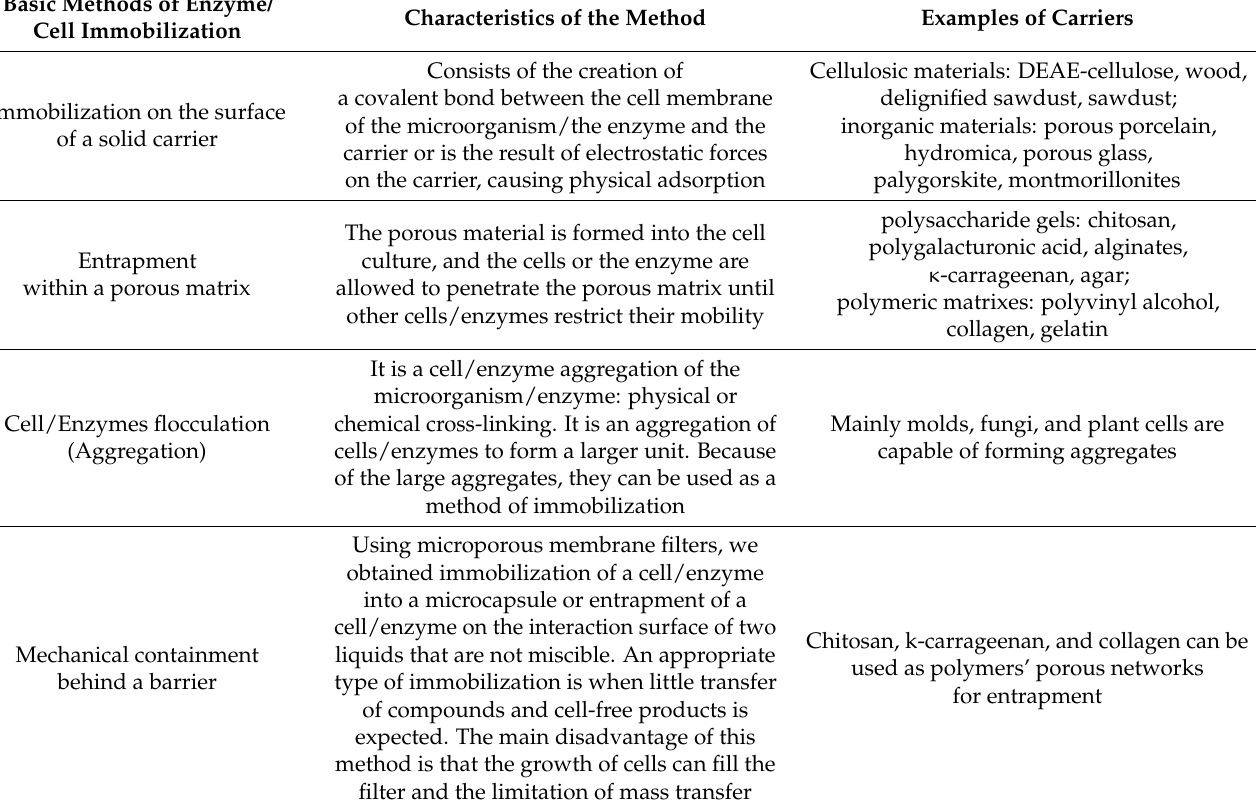
Table 3. Comparison of immobilization